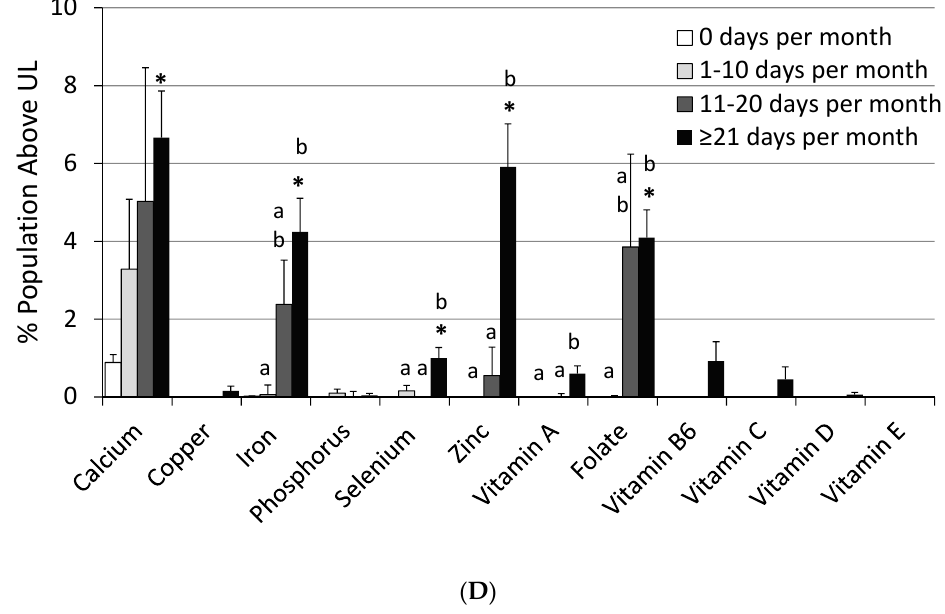
Figure 4. Prevalence of inadequacy (% of population below the EAR) and % population above the UL of other micronutrient intakes from food + MVMS by frequency of MVMS intake among adult females and males age 19 years and older. NHANES 2009–2012. ( A ) Females below EAR; ( B ) Males below EAR; ( C ) Females above UL; ( D ) Males above UL. * Significantly different from 0 days per month at p < 0.01. a,b,c Values by frequency of MVMS with different superscripts are significantly different at p < 0.01. EAR: estimated average requirement; MVMS: multi-vitamin/multi-mineral supplements; NHANES: National Health and Nutrition Examination Survey; UL: upper tolerable intake level.